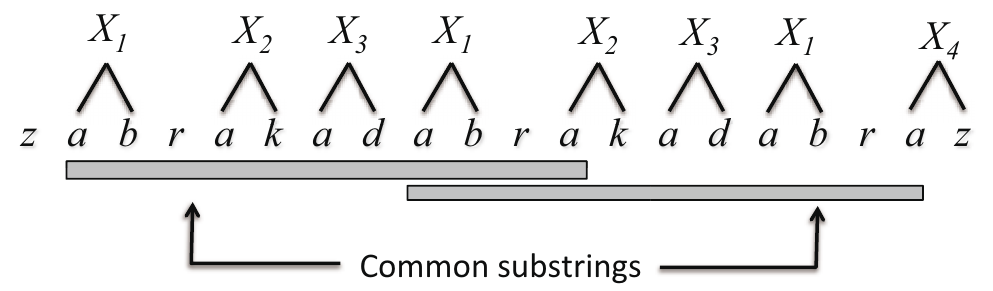
Figure 1. An example of replacing pairs. Our aim is to replace pairs that are almost synchronized in common